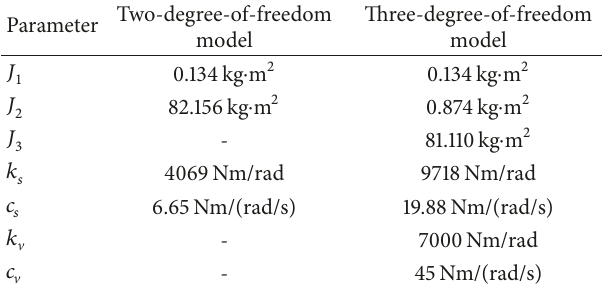
Table 3: Parameters values of the two reduced-order models. Two-degree-of-freedom Parameter